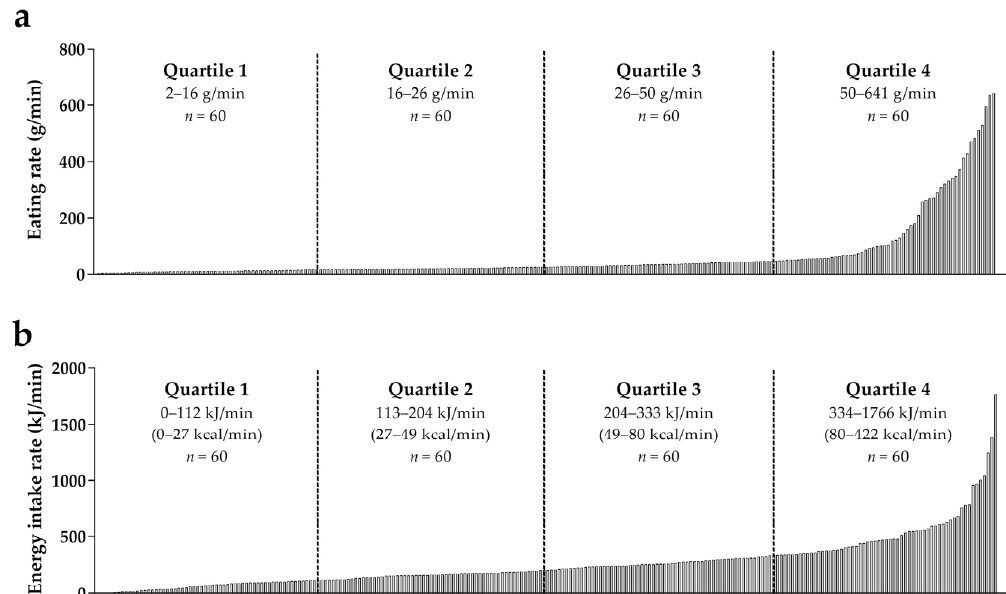
Figure 1. Food ‐ specific eating rate ( a ) and food ‐ specific energy intake rate ( b ) of the foods in the Figure 1. Food-specific eating rate ( a ) and food-specific energy intake rate ( b ) of the foods in the dataset dataset ( n = 240). ( n =